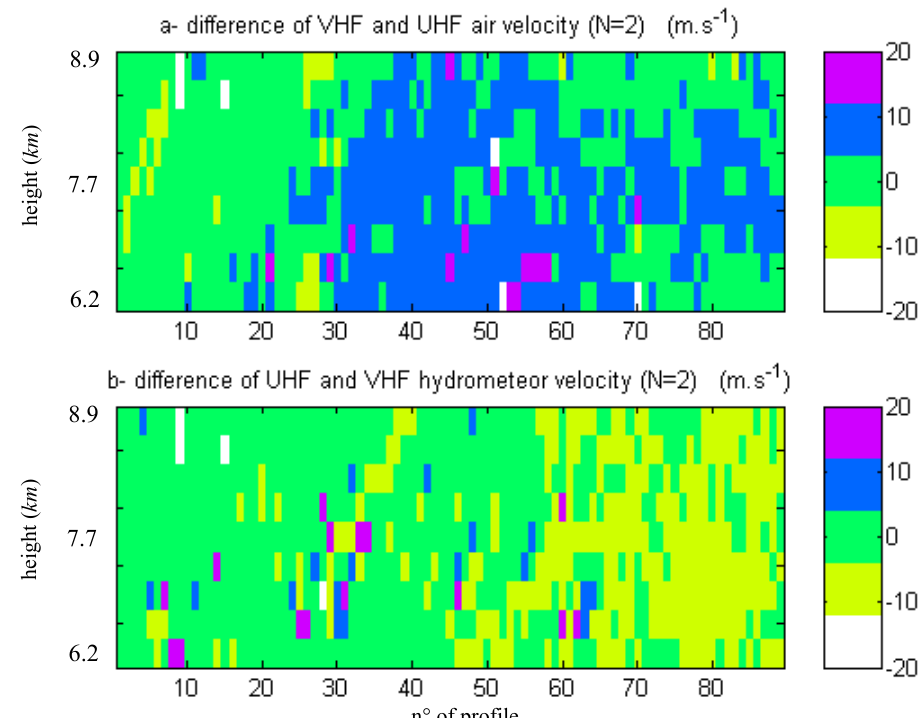
Fig. 7. Difference between VHF and UHF air velocities and between UHF and VHF hydrometeor’s velocities, respectively, assuming N = 2